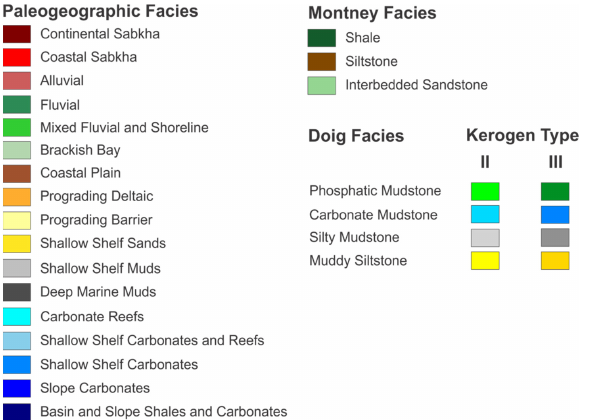
(cid:48) and B–B (cid:48)